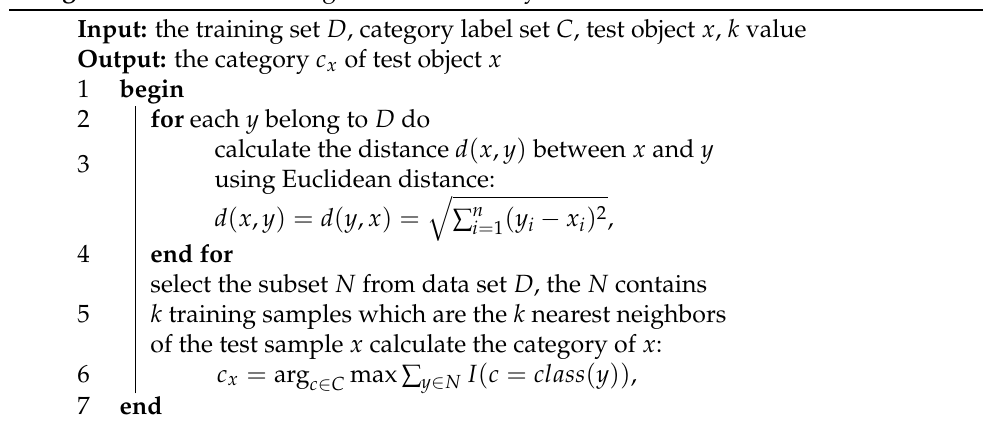
Algorithm 1: The k-NN algorithm for activity